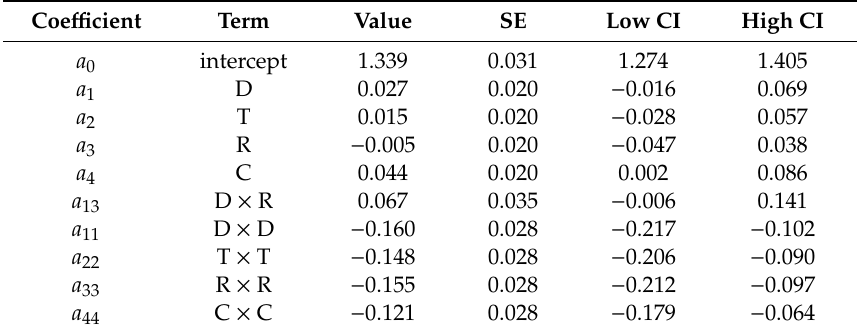
Table 3. Estimated regression coe ffi cients of the reduced model described by Equation (7) with the associated standard errors (SE) and 95%-confidence intervals